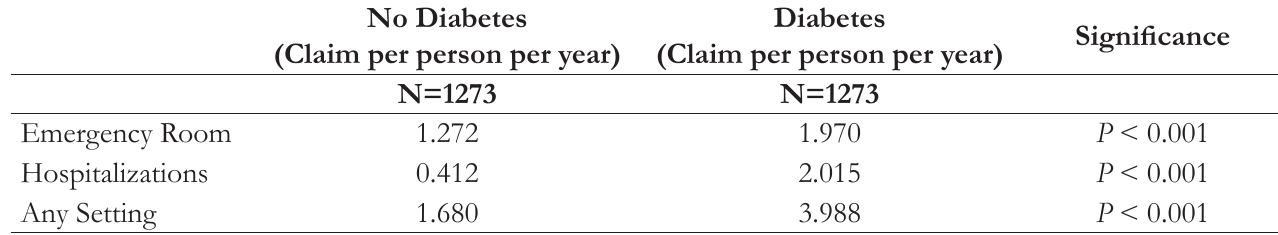
Table 3. Rate of